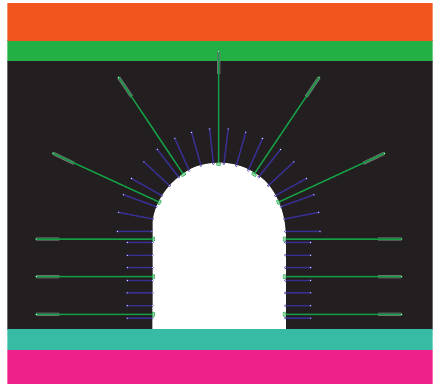
Figure 15: Chamber support